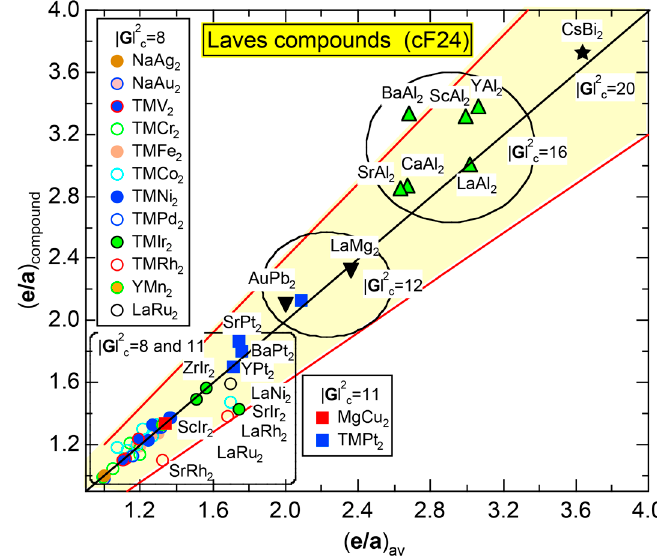
Figure 105. ( e / a ) versus ( e / a ) for Laves compounds studied in [37]. Yellow zone compound av is bounded by the two lines, one higher and the other lower by 20% relative to the line ( e / a ) = ( e / a ) compound av